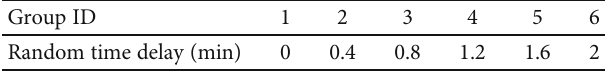
Table 4: Random time delay of the MAS mode for simulation.